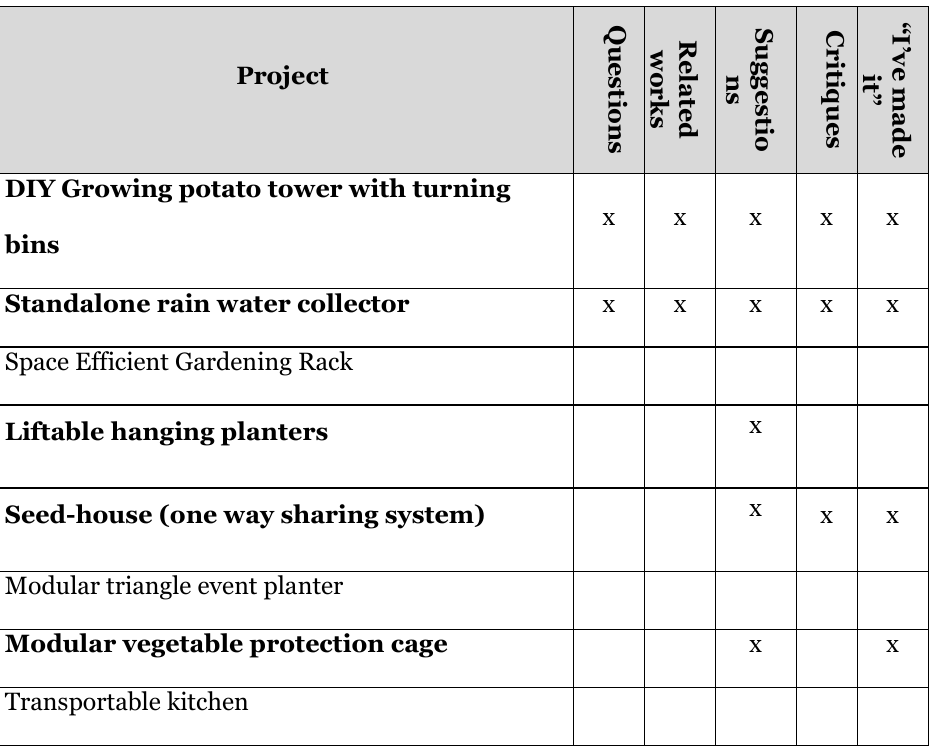
The Combinations of Projects with Specific Types of Comments are Marked with